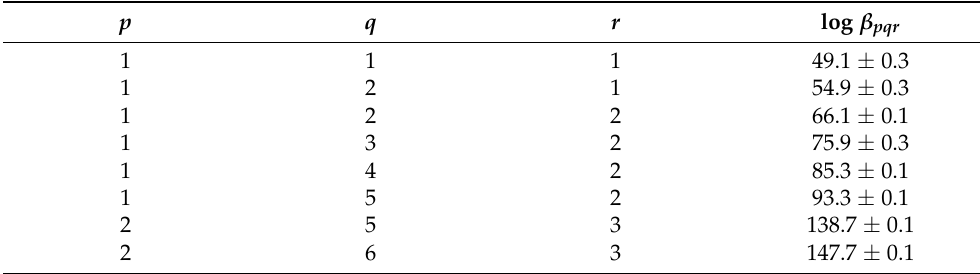
Table 2. The log β pqr of Zr-DFO complexes determined in this